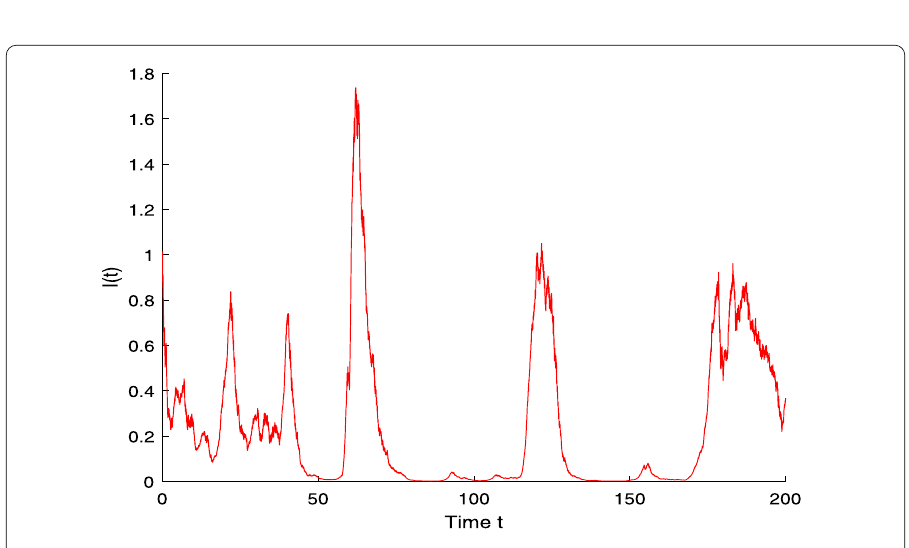
Figure 2 The sample path of I ( t ) with S (0) = 2, I (0) = 1. Here α (1) = 0.7 and α (2) = 0.3. In this case, β ( i ) < α ( i )( ε ( i ) + γ ( i )), i ∈